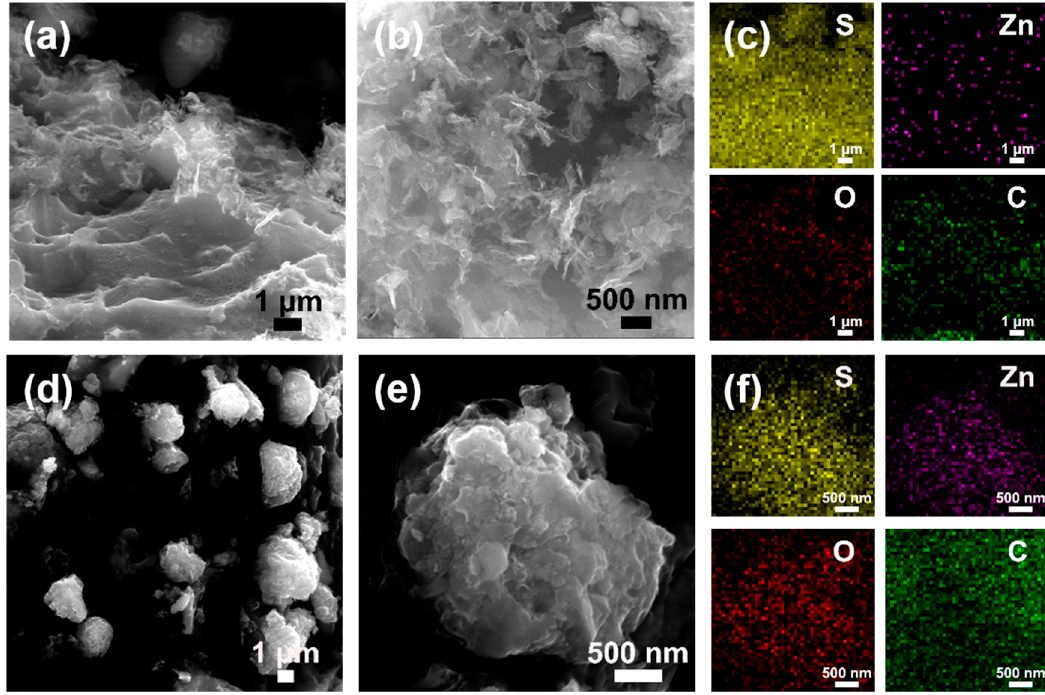
Figure 4. SEM images of S-ZnO / rGO ( a , b ) and corresponding element distribution ( c ). SEM images of S-3D-ZnO / rGO ( d , e ) and corresponding element distribution ( f ).